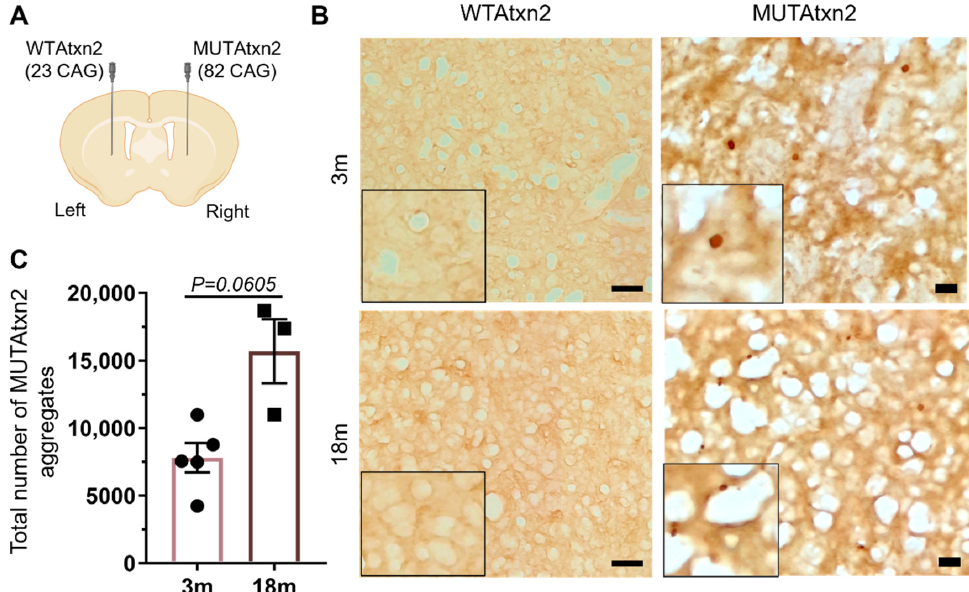
Figure 1. Aged animals displayed a higher number of MUTAtxn2 aggregates. ( A ) Schematic representation of striatal injection of lentiviral vectors encoding for WTAtxn2 (23 CAG repetitions) or expanded MUTAtxn2 (82 CAG repetitions). ( B ) Immunohistochemistry of mouse striatal slices stained for ataxin-2. Scale bar 20 µ m. ( C ) Quantitative analysis of the number of aggregates 12 weeks post-MUTAtxn2 injection in the 3-month-old ( n = 5) and 18-month-old animal groups ( n = 3). Values are expressed ± SEM (standard error of the mean) (unpaired t -test with Welch’s correction).